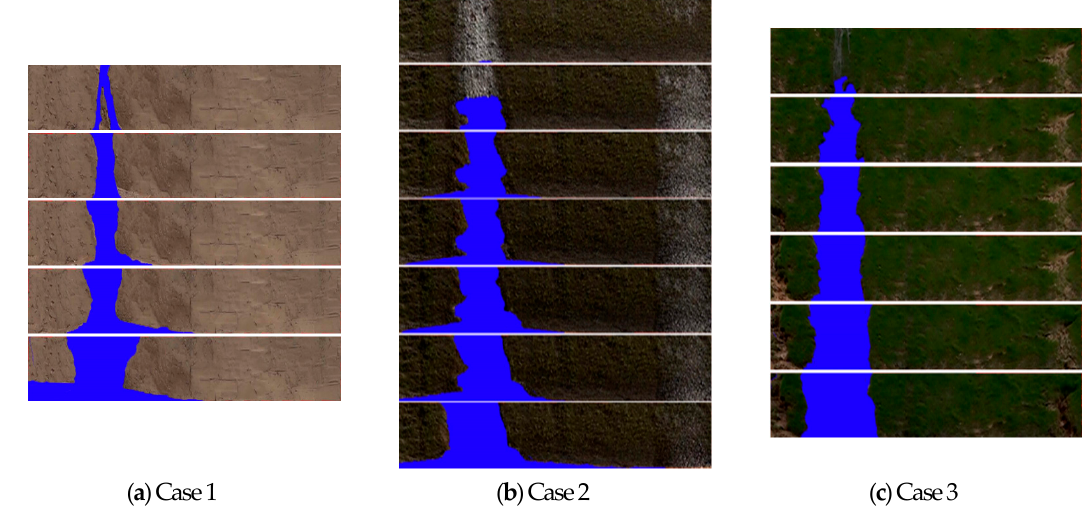
Figure 7. Changes in real-time levee collapse width under different experimental conditions; ( a ) sand levee, ( b ) reinforced novel materials levee, and ( c ) vegetation levee (the width is 5.6 m, and the length is 12 m).